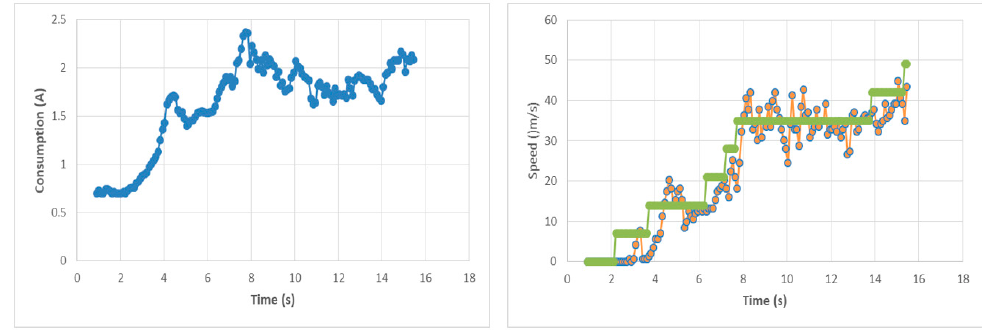
Figure 13. Experiments of evaluating the amperage consumption of the robot ( left ) and its actual speed response to speed alteration directions ( right ).